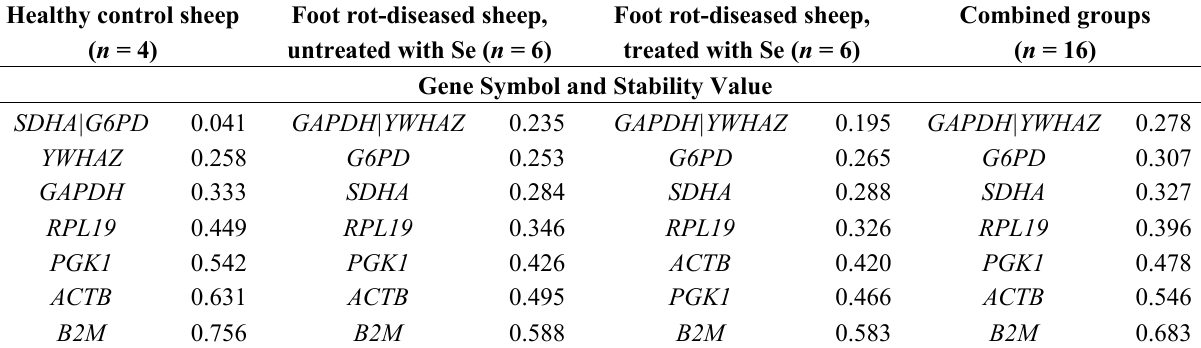
Table 3. Stability ranking of candidate reference genes in healthy control and foot rot-affected sheep, with or without selenium (Se) treatment, and in combined groups, by the geNorm algorithm (lower stability values indicate more stable gene